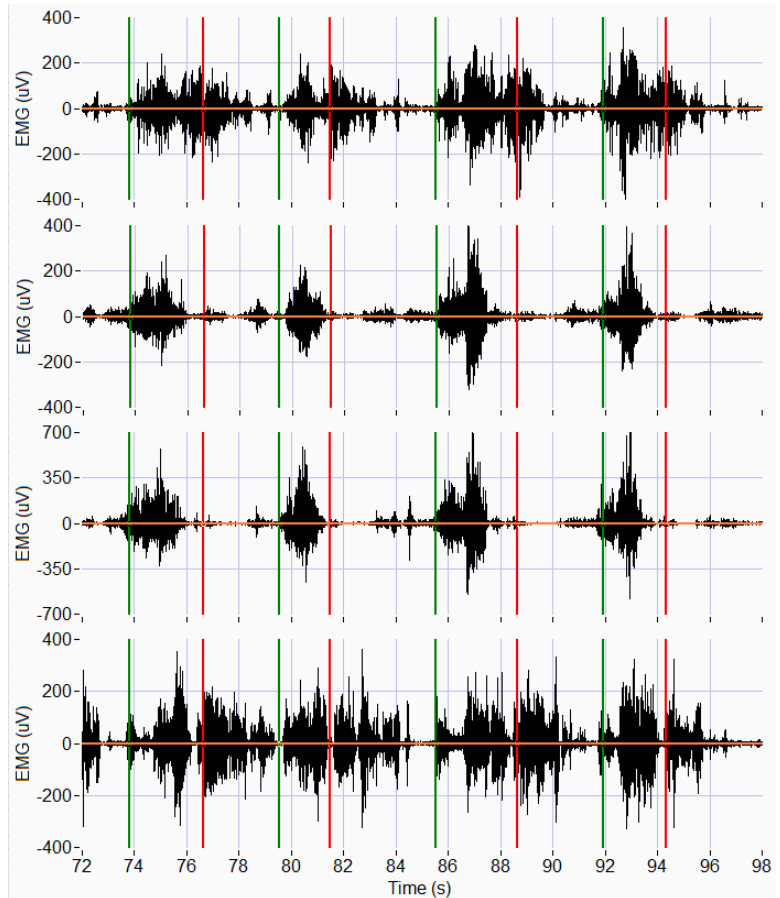
Figure 4. Surface EMG signals acquired simultaneously from four muscles. From top to bottom: erector spinae, gluteus medius, quadriceps femoris, semitendinosus. Time window corresponds to last 4 movements of exercise by subject 4 without exoskeleton. Vertical marks indicate beginning (green) and end (red) of myoelectrical activation, before visual check carried out to catch the boxes. Six parameters were calculated for each of the 16 segments